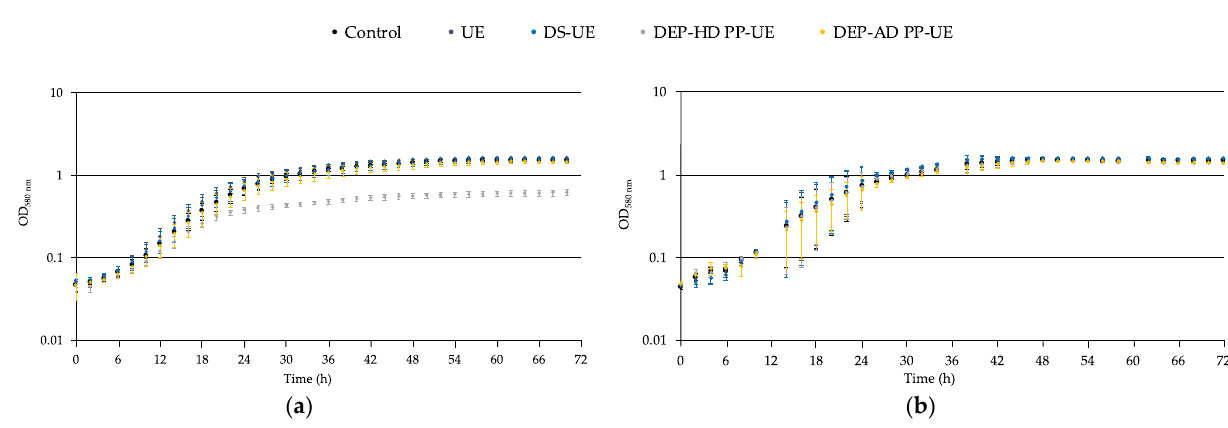
Figure 3. Effects of poly- and oligosaccharide Ulva sp. fractions on the growth kinetic of ( a ) C. acnes RT4 and ( b ) C. acnes RT6. The representation of the growth kinetic curve and error standard of each measurement are in log 10 scale.